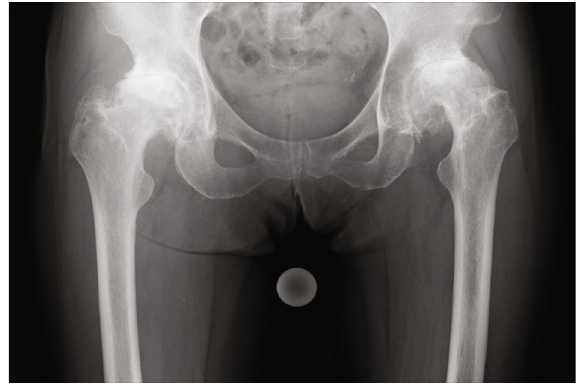
Figure 2: The plain radiograph before surgery. End-stage osteoarthritis was revealed in both hips.